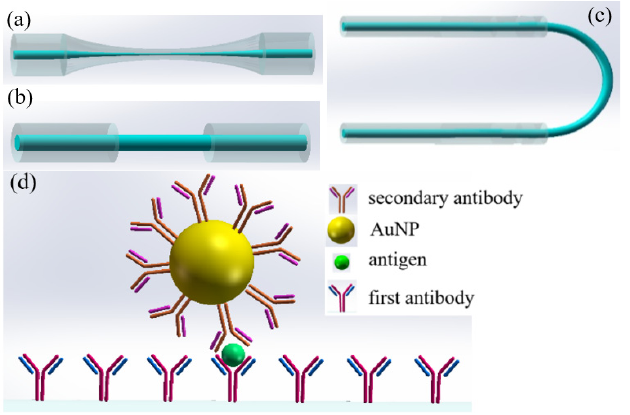
Figure 2. The schematic diagram of ( a ) microfiber, ( b ) unclad fiber, ( c ) U-bent unclad fiber, and ( d ) gold-linked sandwich immunoassay.